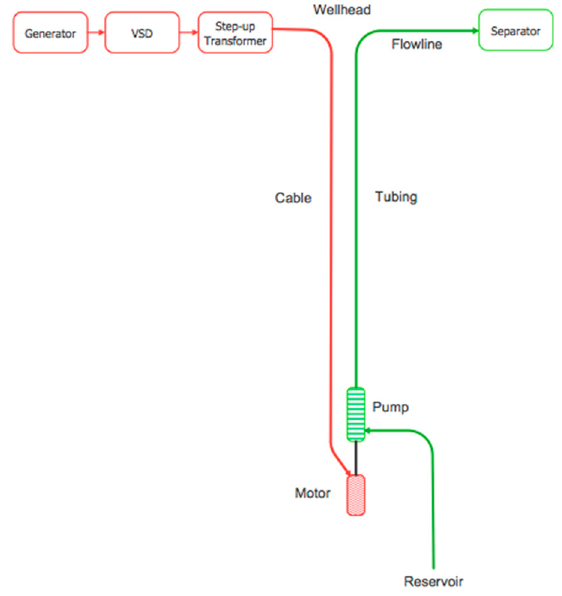
Figure 3. ESP system electrical and hydraulic components.